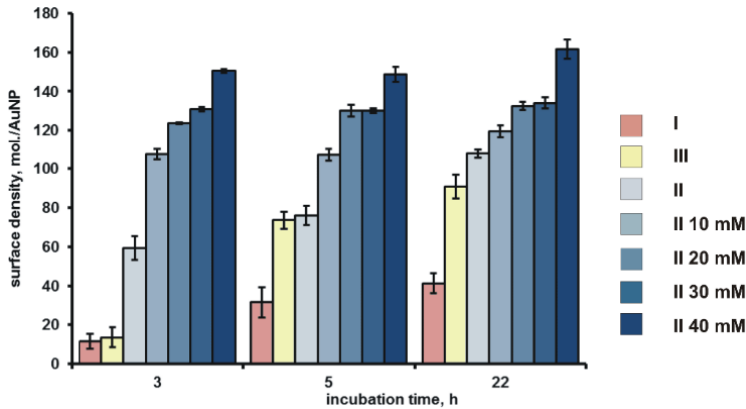
Figure 4. Surface density of siRNA in the composition of a core in Samples I–III. Right column shows type of a sample and NaCl concentration (10–40 mM).